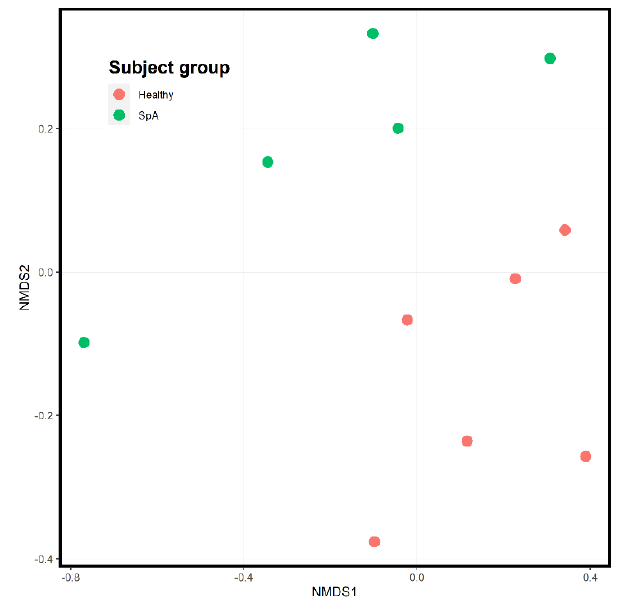
Children 2022 , 9 , x FOR PEER REVIEW Figure 6. Ordination analysis of salivary samples obtained from healthy control subjects and children with Spondyloarthritis (SpA). The SpA subjects are the green circles, while the controls are depicted in red.